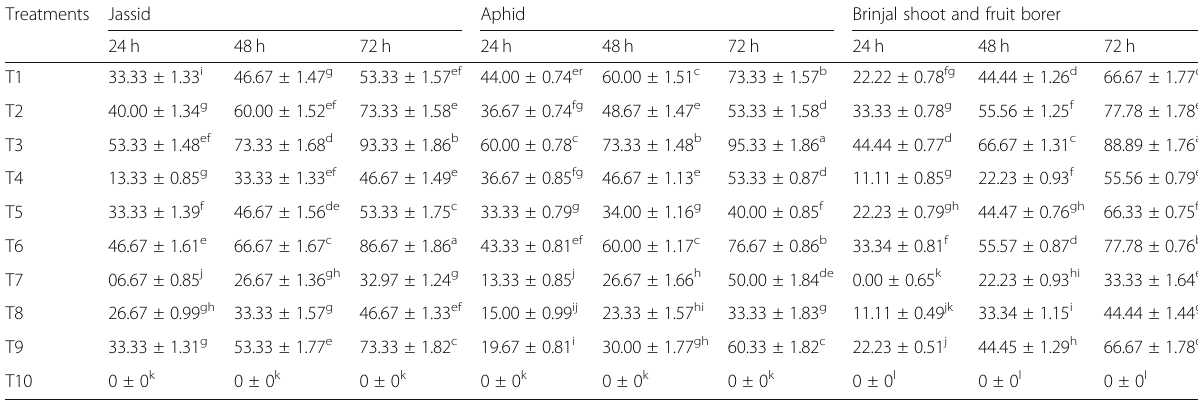
Table 2 Means percentage mortality of jassid, aphid, and brinjal shoot and fruit borer after entomopathogen treatments with different time intervals in leaf dip bioassay under laboratory condition . (values with different lower case letters show significant difference at 0.05 significance